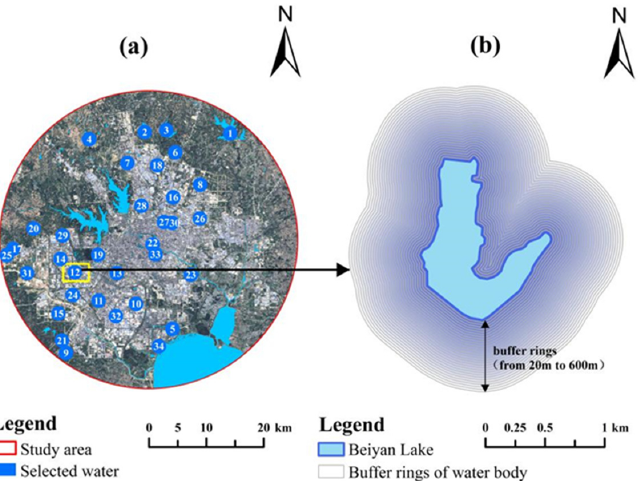
Figure 3. ( a ) Spatial distributions of the 34 selected water bodies in Hefei. ( b ) The establishment of buffer zones of water